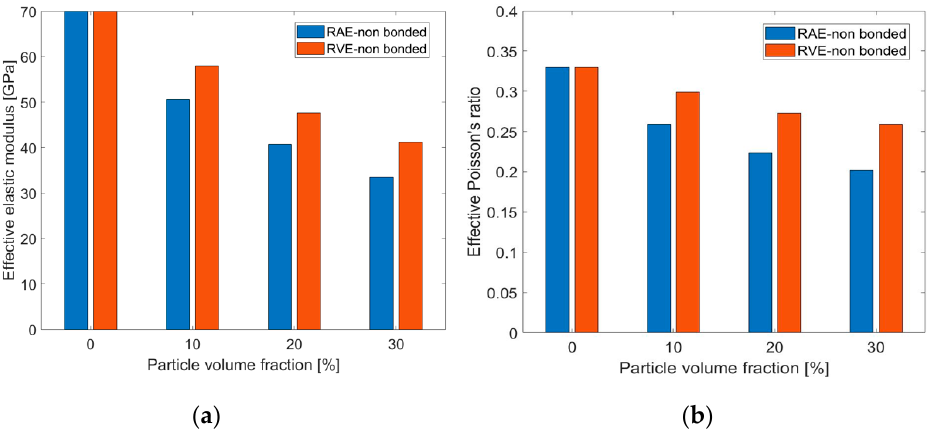
Figure 8. Comparison between effective elastic modulus ( a ) and Poisson’s ratio ( b ) obtained from 2D and 3D numerical models with nonbonded interface conditions for different particle volume fraction values.